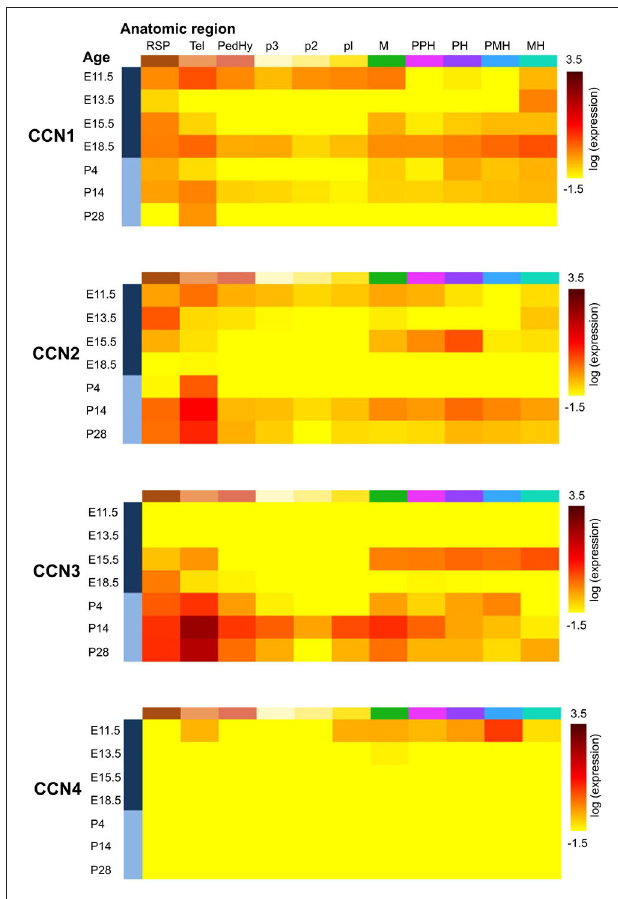
FIGURE 2 | Expression of CCN1–4 genes in the developing mouse brain according to the Allen Developing Mouse Brain Atlas [© 2013 Allen Institute for Brain Science . Allen Developing Mouse Brain Atlas (Internet)] . Gene expression summary for selected brain structures were downloaded from http://developingmouse.brain-map.org/ and are expressed as a heatmap of expression energy (for more details please refer to http://help.brain-map.org/display/devmouse/In+Situ+Hybridization+ (ISH)+Data#InSituHybridization(ISH)Data-CorrelationSearch). Heatmaps source: CCN1: http://developingmouse.brain-map.org/gene/show/15780; CCN2: http://developingmouse.brain-map.org/gene/show/13996; CCN3: http://developingmouse.brain-map.org/gene/show/17900; CCN4: http://developingmouse.brain-map.org/gene/show/22159.